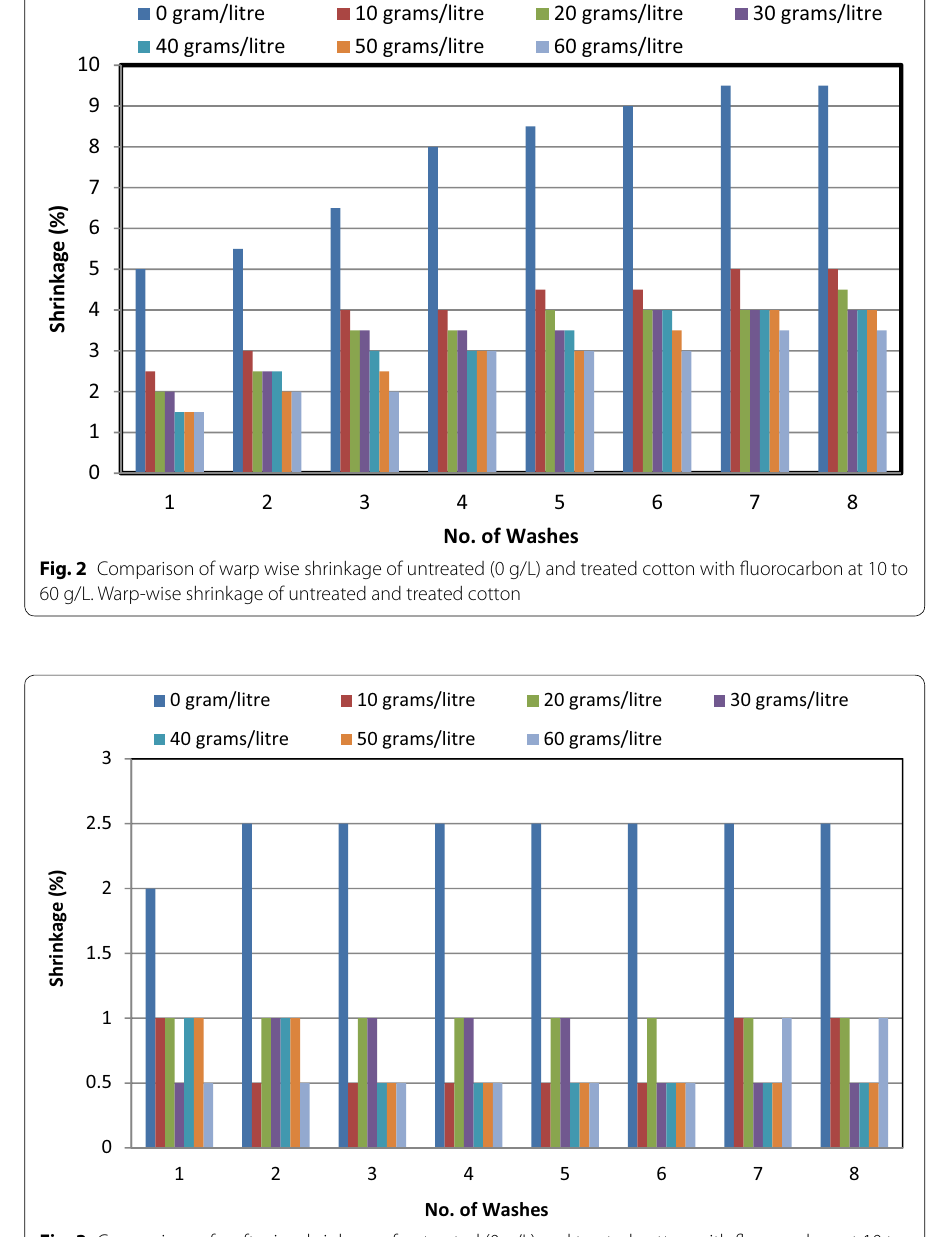
Fig. 3 Comparison of weft wise shrinkage of untreated (0 g/L) and treated cotton with fluorocarbon at 10 to 60 g/L. Weft-wise shrinkage of untreated and treated